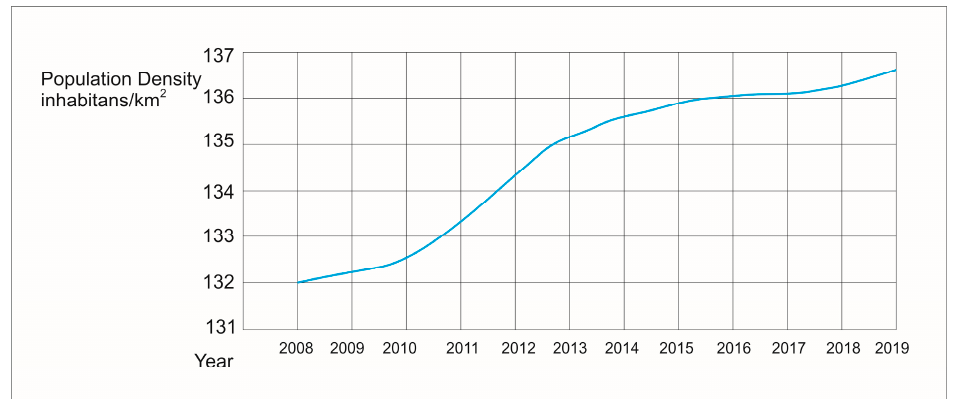
Figure 3. Population density in the Czech Republic (2004–2019).